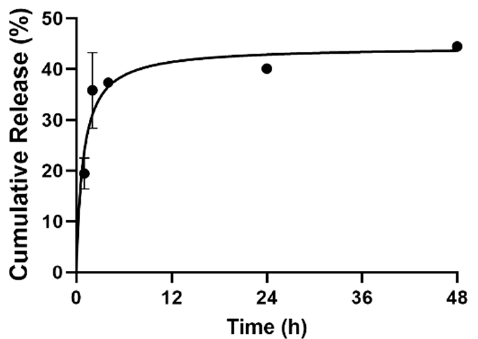
Figure 1. In Vitro cumulative release profile of LO from LONs over a two-day period. Graphic made with GraphPad Prism 9.0 ( n = 3).